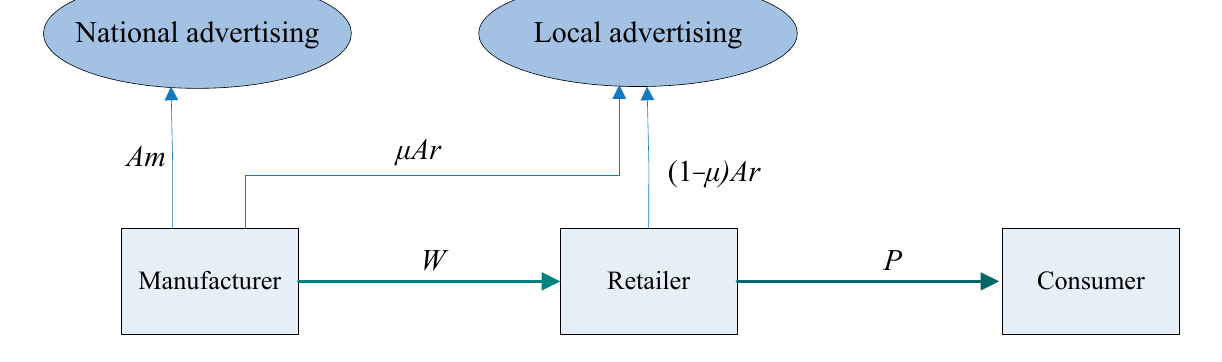
Figure 1. The model framework. Table 1. Notations.